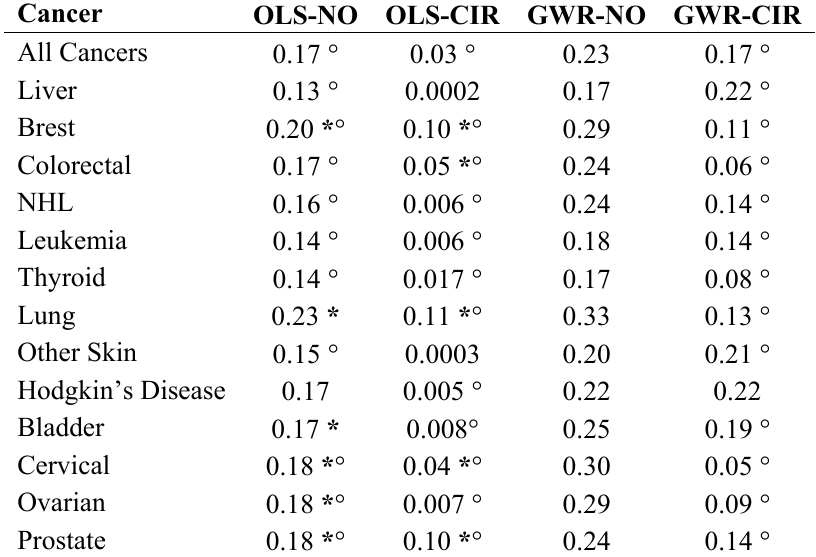
Table 4. Association between NO